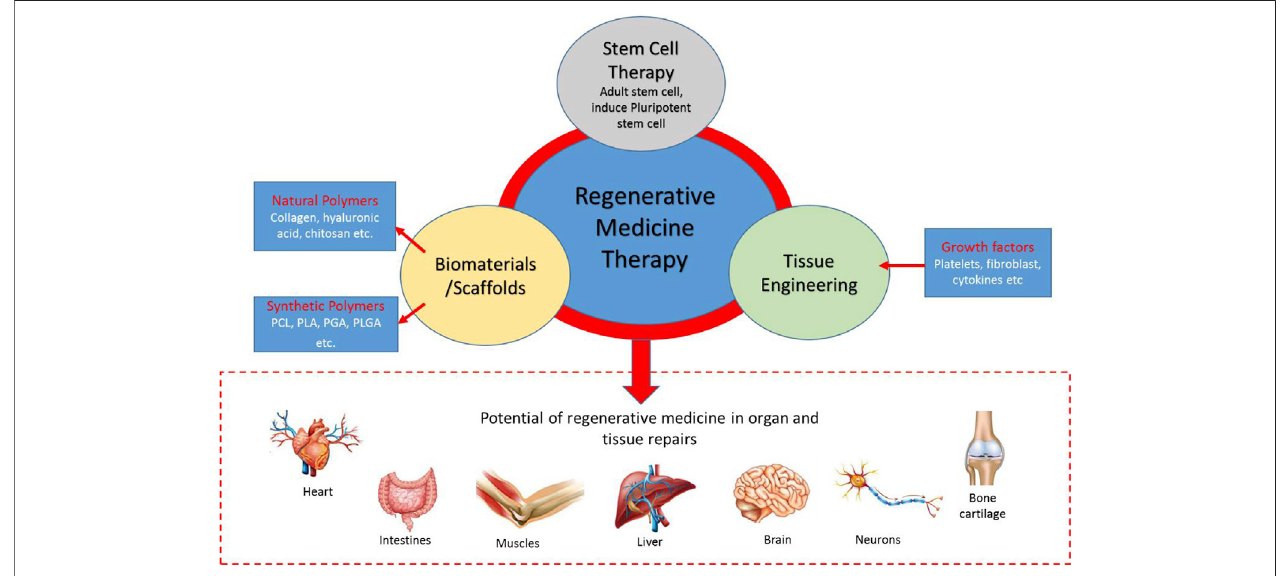
FIGURE 1 | The regenerative medicine therapy (RMT) triad. Stem cell therapy, biomaterials/scaffolds, and tissue engineering are components of regenerative medicine in organ/tissue repairs.